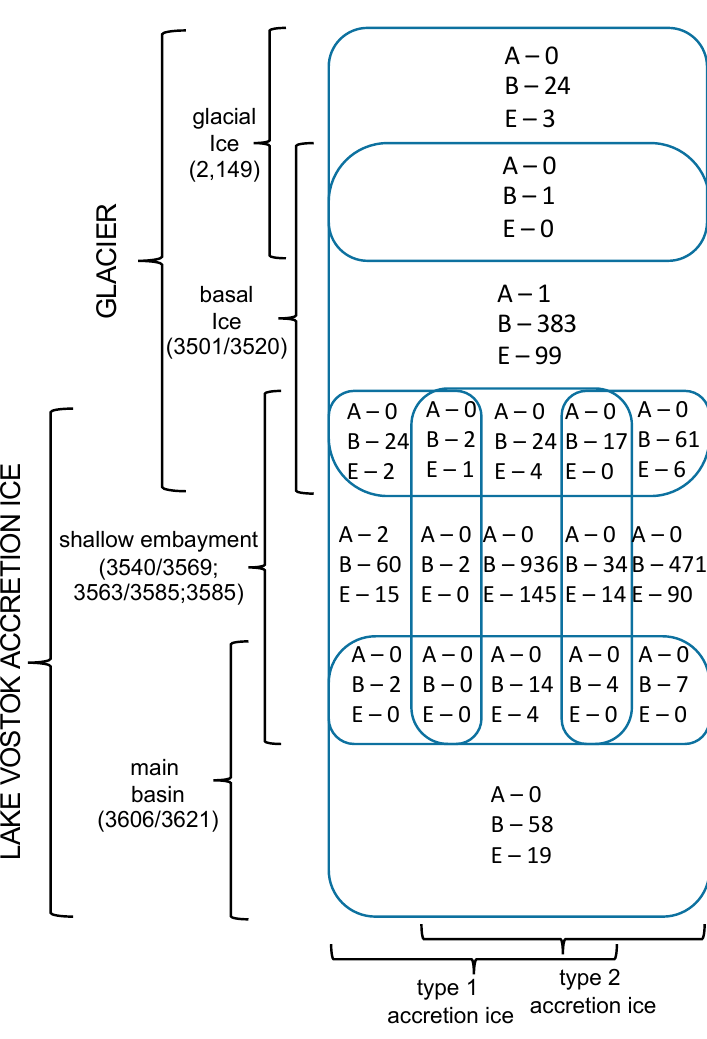
Figure 3. Venn diagram indicating the numbers of unique sequences in each core sample, and the numbers of sequences that are found in adjacent samples (overlapping rounded rectangles). Domain abbreviations are as in Figure 2.